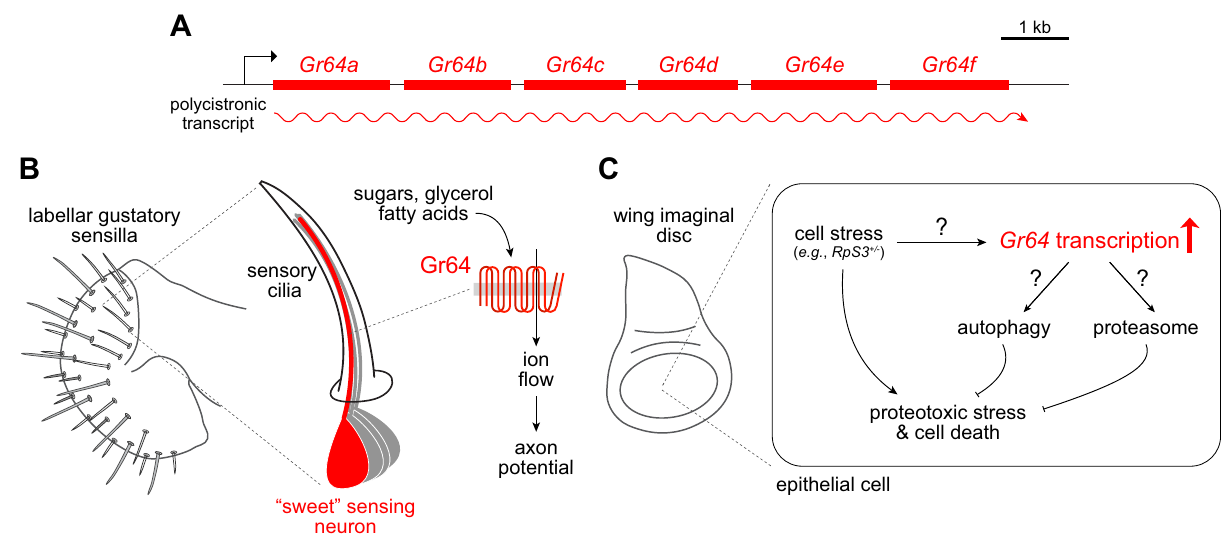
Fig 1. Tissue-specific roles for Gr64 receptors in taste sensing and cell stress sensing. (A) Schematic of the tandem cluster of Gr64 genes, which are thought to be transcribed as a polycistronic transcript [9]. (B) Left: cartoon of the Drosophila feeding organ, the labellum, which is covered in gustatory sensilla housing different types of ciliated sensory neurons. Middle: Gr64 genes are expressed, in various combinations, in typically a single “sweet”- sensing neuron in each sensillum. Right: individual Gr64 proteins contain 7 transmembrane domains and likely assemble into homo- or heteromeric complexes to form ligand-gated ion channels responding to appetitive chemicals, including many sugars, glycerol, and fatty acids [6]. (C) Model for the role of Gr64 genes in promoting proteostasis and cell survival in imaginal discs under proteotoxic stress (see text); the mechanistic function of Gr64 genes in this process is unclear, but is thought to be largely cell autonomous